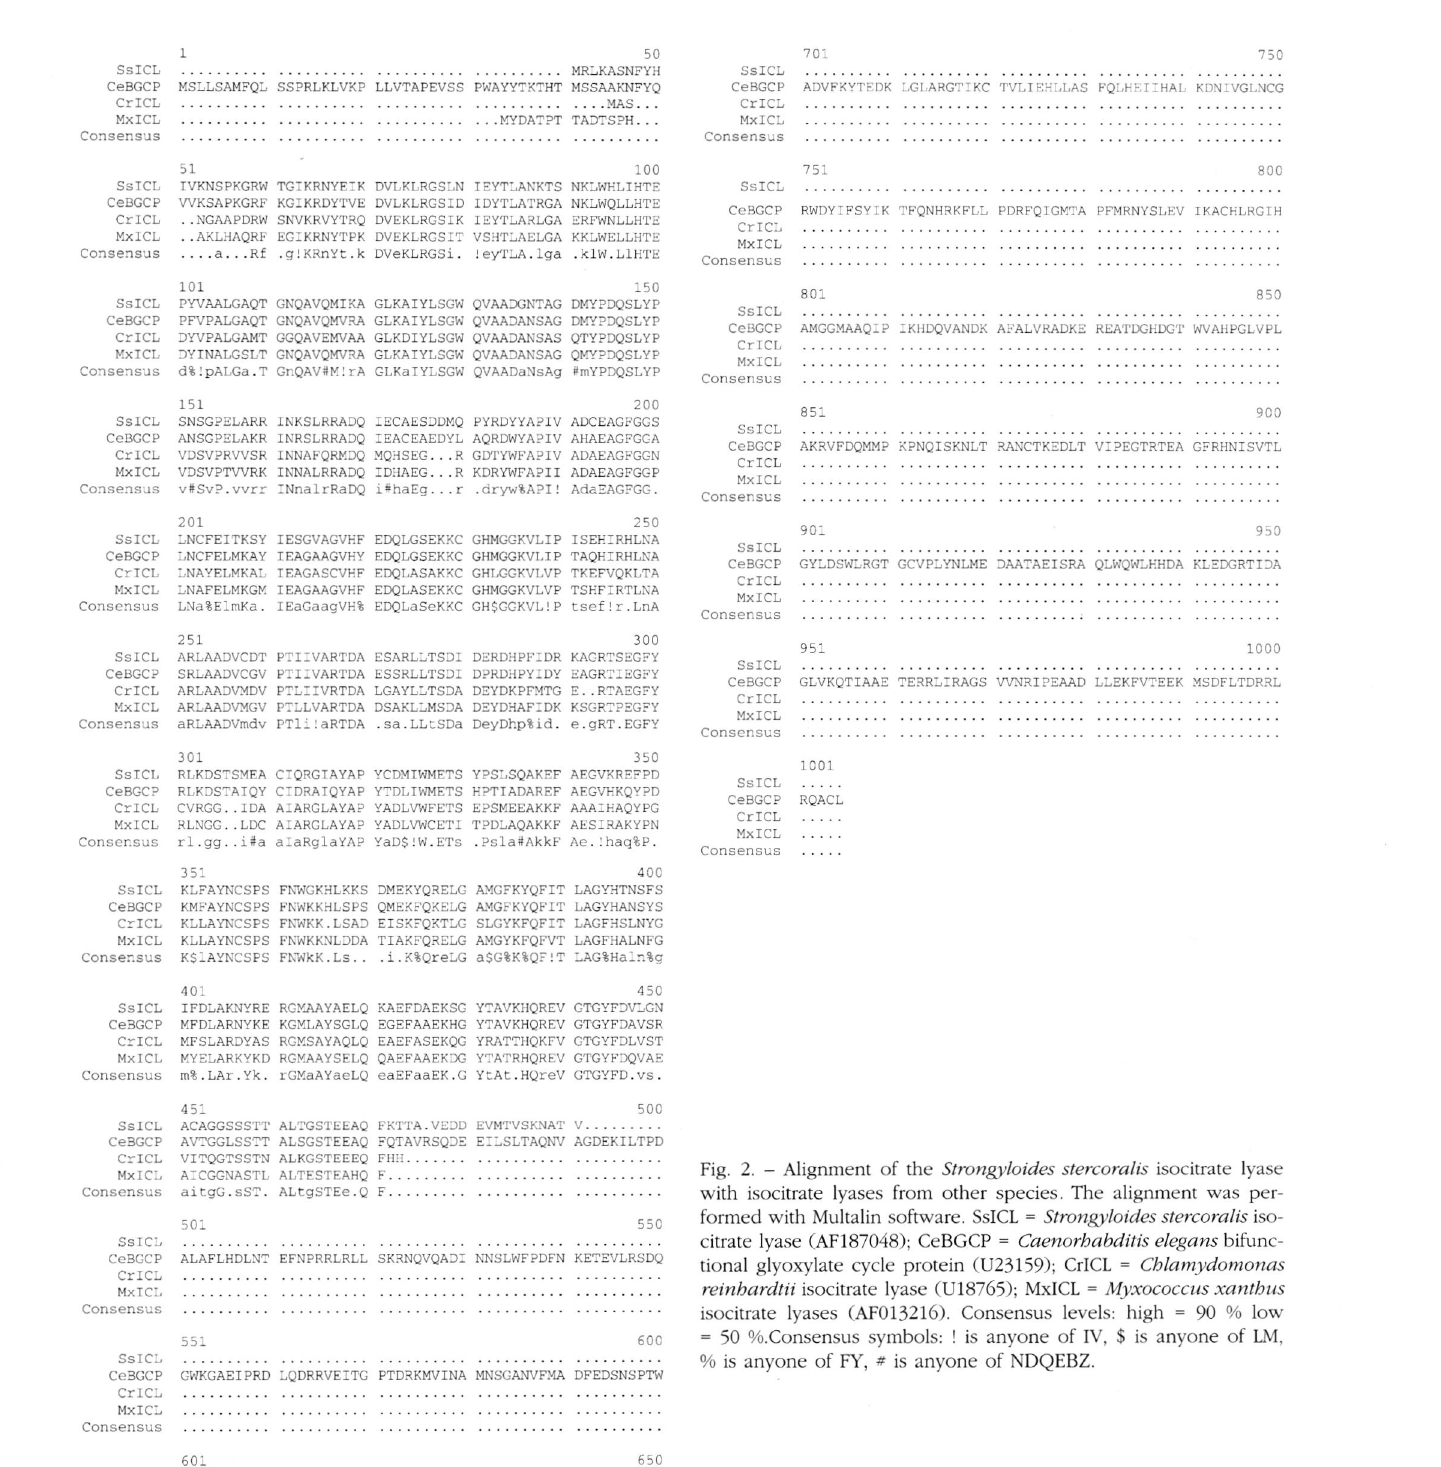
Fig. 2. - Alignment of the Strongyloides stercoralis isocitrate lyase with isocitrate lyases from other species. The alignment was per­ formed with Multalin software. SsICL = Strongyloides stercoralis iso­ citrate lyase (AF187048); CeBGCP = Caenorhabditis elegans bifunc- tional glyoxylate cycle protein (U23159); CrICL = Chlamydomonas reinhardtii isocitrate lyase (U18765); MxICL - Myxococcus xanthus isocitrate lyases (AF013216). Consensus levels: high = 90 % low = 50 %.Consensus symbols: ! is anyone of IV, $ is anyone of LM, % is anyone of FY, # is anyone of